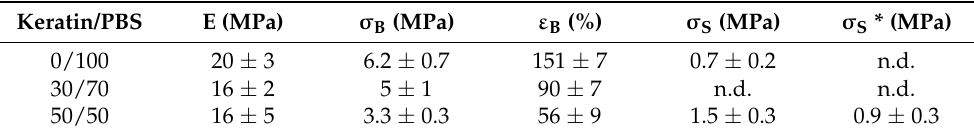
Table 2. Tensile and adhesion tests data of PBS and Keratin/PBS 50/50 electrospun